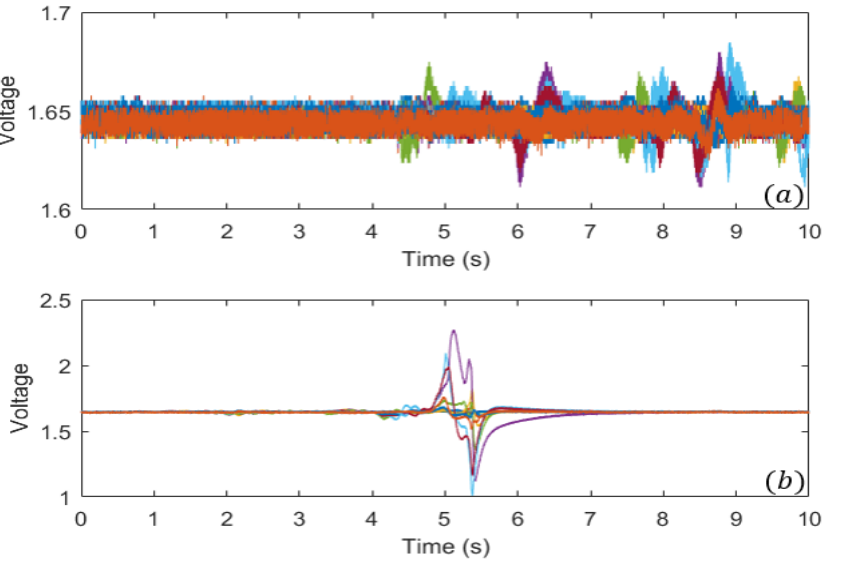
Figure 3. Touch Modalities: ( a ) touch with noisy readings; and ( b ) touch with silent